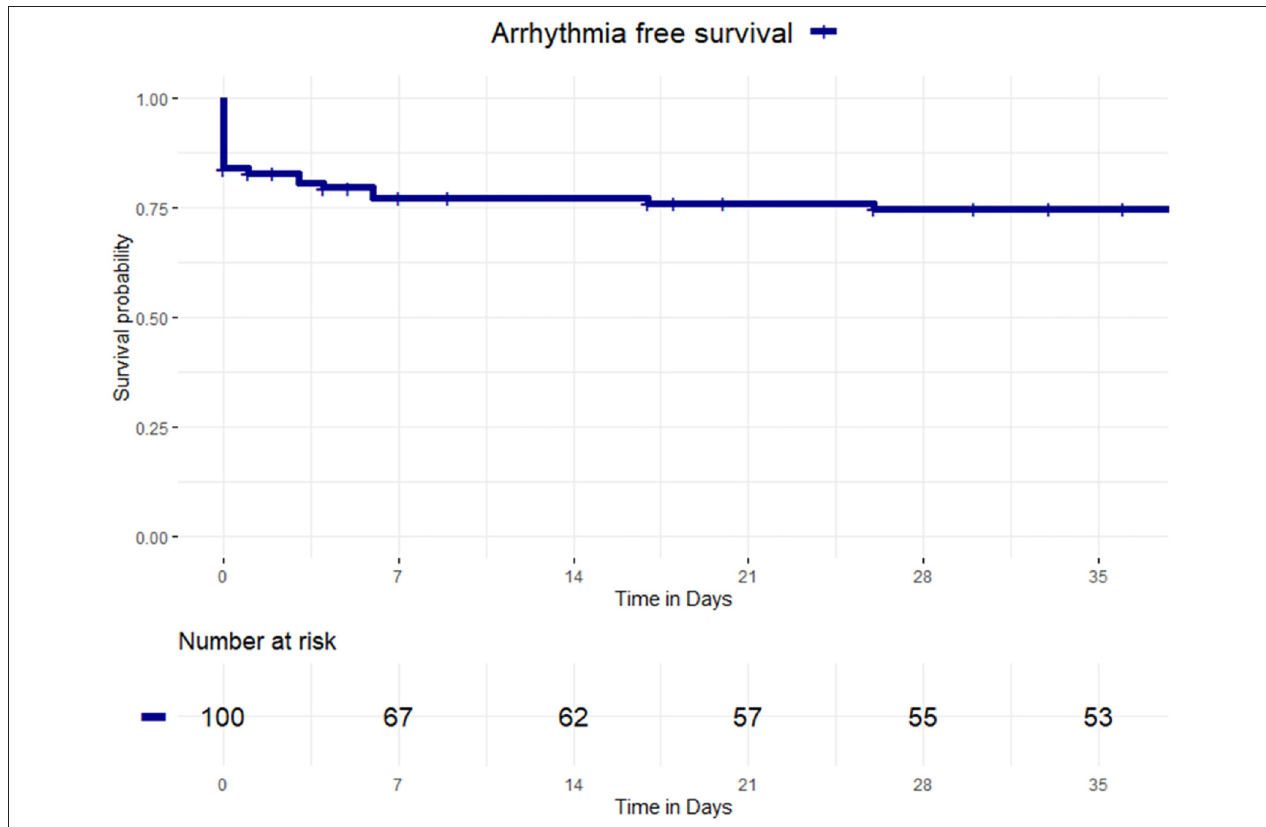
FIGURE 1 | Kaplan-Meier curves of survival free from arrhythmia occurrence. Kaplan-Meier curve of survival free from any arrhythmia in patients with coronavirus disease 2019 (COVID-19).